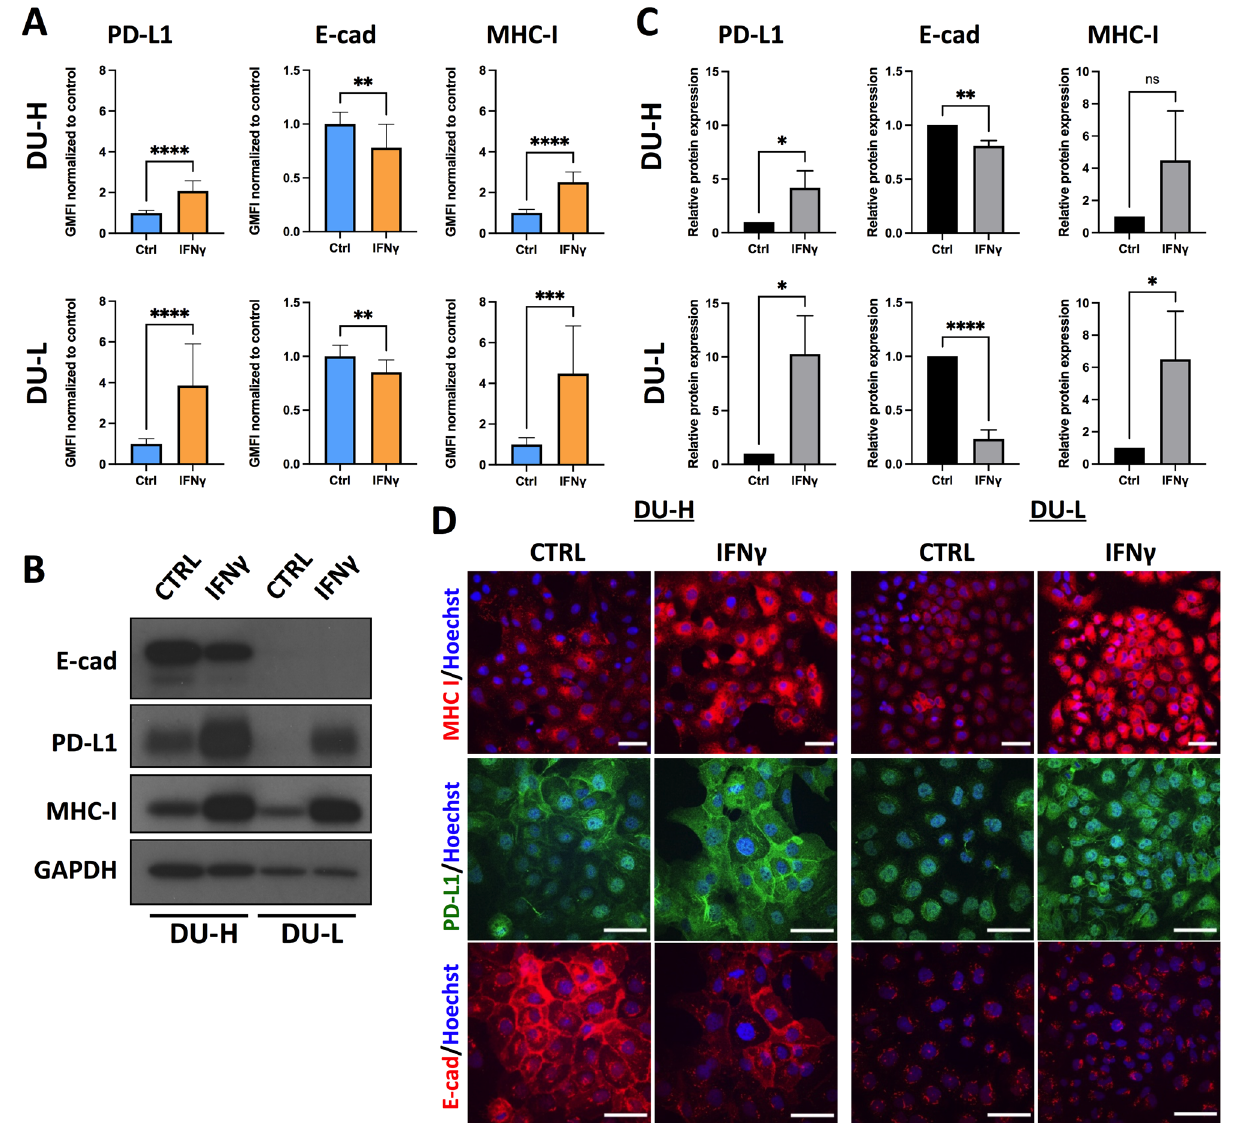
Figure 1. IFNγ treatment alters the expression of MHC-I, PD-L1 and E-cadherin in mCRPC cells. ( A ) Geometric Mean Fluorescence Intensity (GMFI) of E-cadherin, MHC-I, and PD-L1 total expression in DU-H and DU-L cells after treatment with control or IFNγ (5 ng/mL) for 48 h, determined by flow cytometry. ( B ) Immonoblot of E-cadherin, PD-L1, and MHC-I in DU-H and DU-L cells after control or IFNγ (5 ng/ mL) treatment for 48 h, with GAPDH as loading control. Uncropped immunoblot images are located in supplementary figures (Fig. S2). ( C ) Quantification of immunoblots with fold change compared with control. Data shown as mean ± SD of three independent experiments. Student t-test * p < 0.05, ** p < 0.005, *** p < 0.001 **** p < 0.0001, ns, not significant. ( D ) Representative immunofluorescence (IF) images of staining MHC-I (red), PD-L1 (green), E-cadherin (red), and Hoechst 33342 (blue) in DU-H and DU-L. Cells were treated with control or IFNγ (5 ng/mL) for 48 h. All scale bars, 50